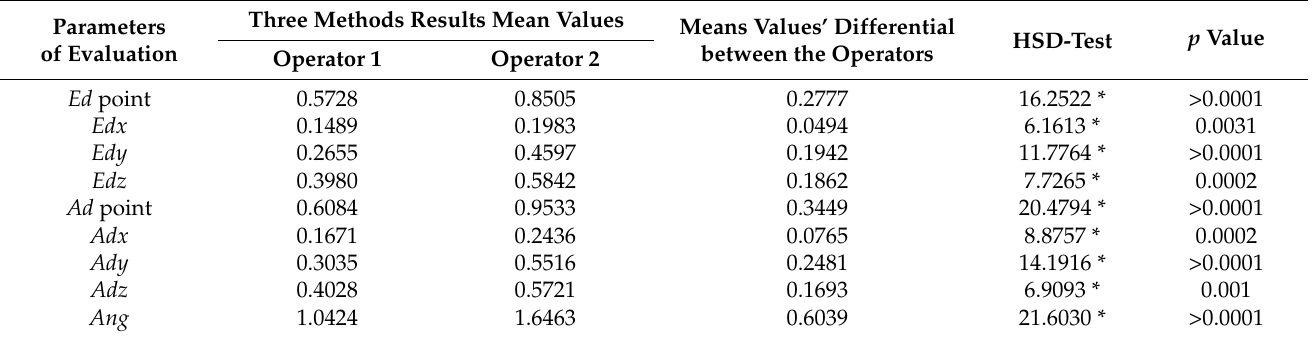
Table 1. Pairwise ANOVA analysis (Tukey HSD test) correlating the dependent variables with the three methods’.